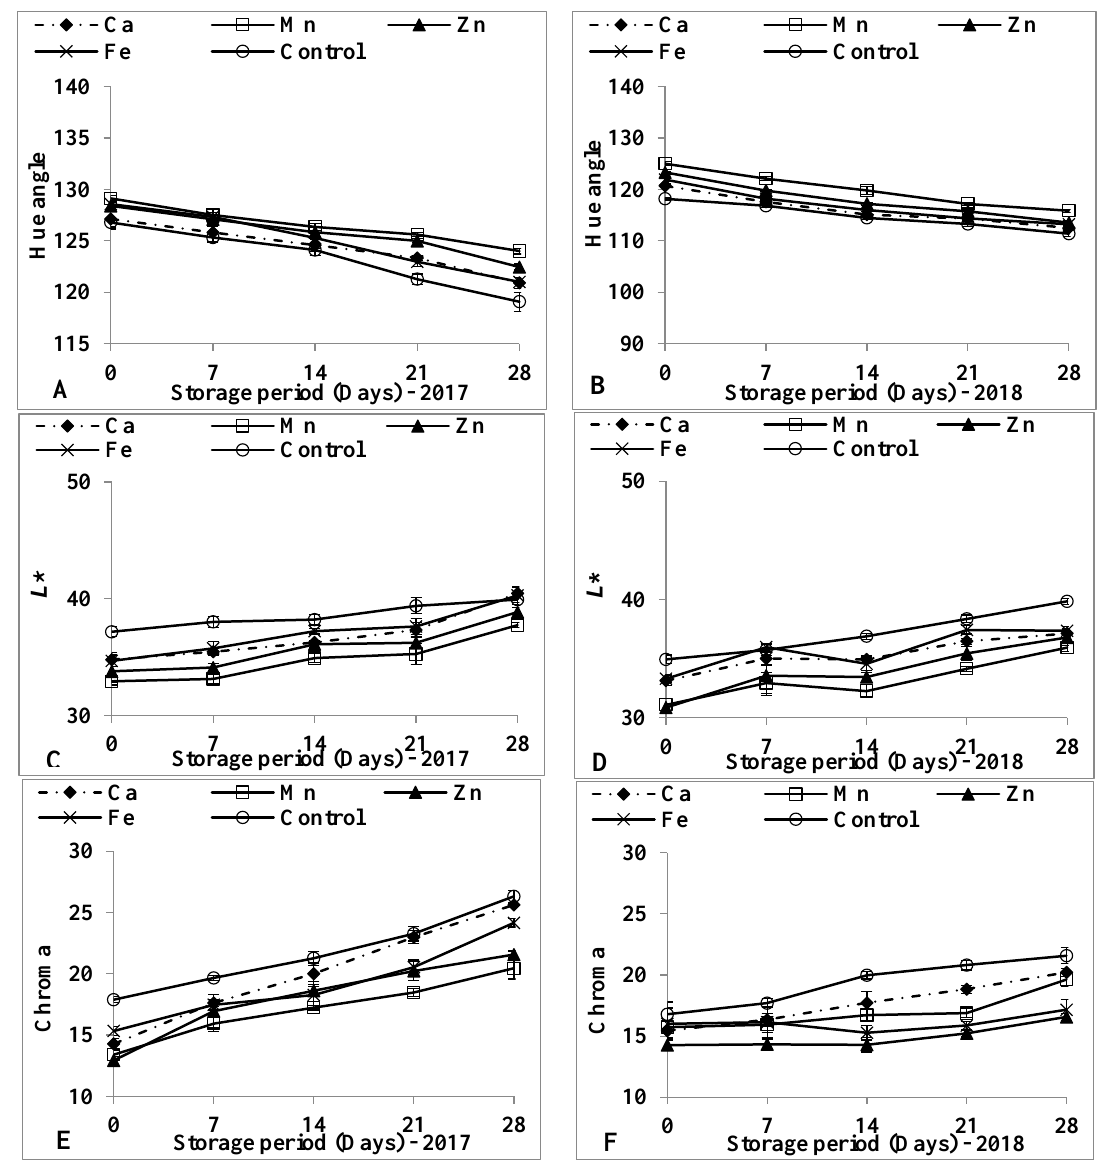
Figure 2. Effect of foliar application with Ca, Mn, Zn, and Fe elements on ( A ) Hue angle in 2017, ( B ) Hue angle in 2018, ( C ) L* values in 2017, ( D ) L* values in 2018, ( E ) Chroma in 2017, and ( F ) Chroma in 2018 of broccoli florets stored for 28 days at 4 °C. Different letters indicate significant differences between treatments (Tukey test at p < 0.05).